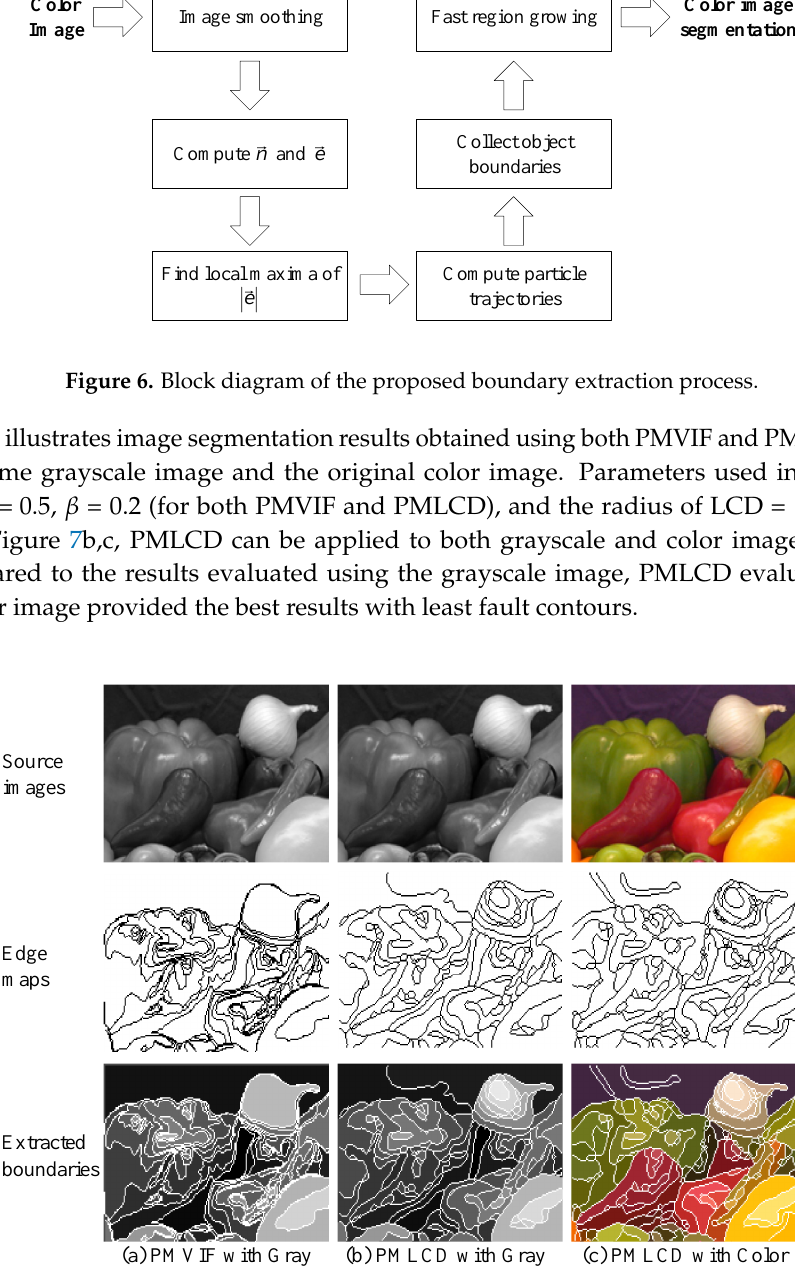
Figure 7. Image segmentation results obtained using ( a ) PMVIF and ( b ) PMLCD are evaluated using the same grayscale image and ( c ) the PMLCD result evaluated using the original color